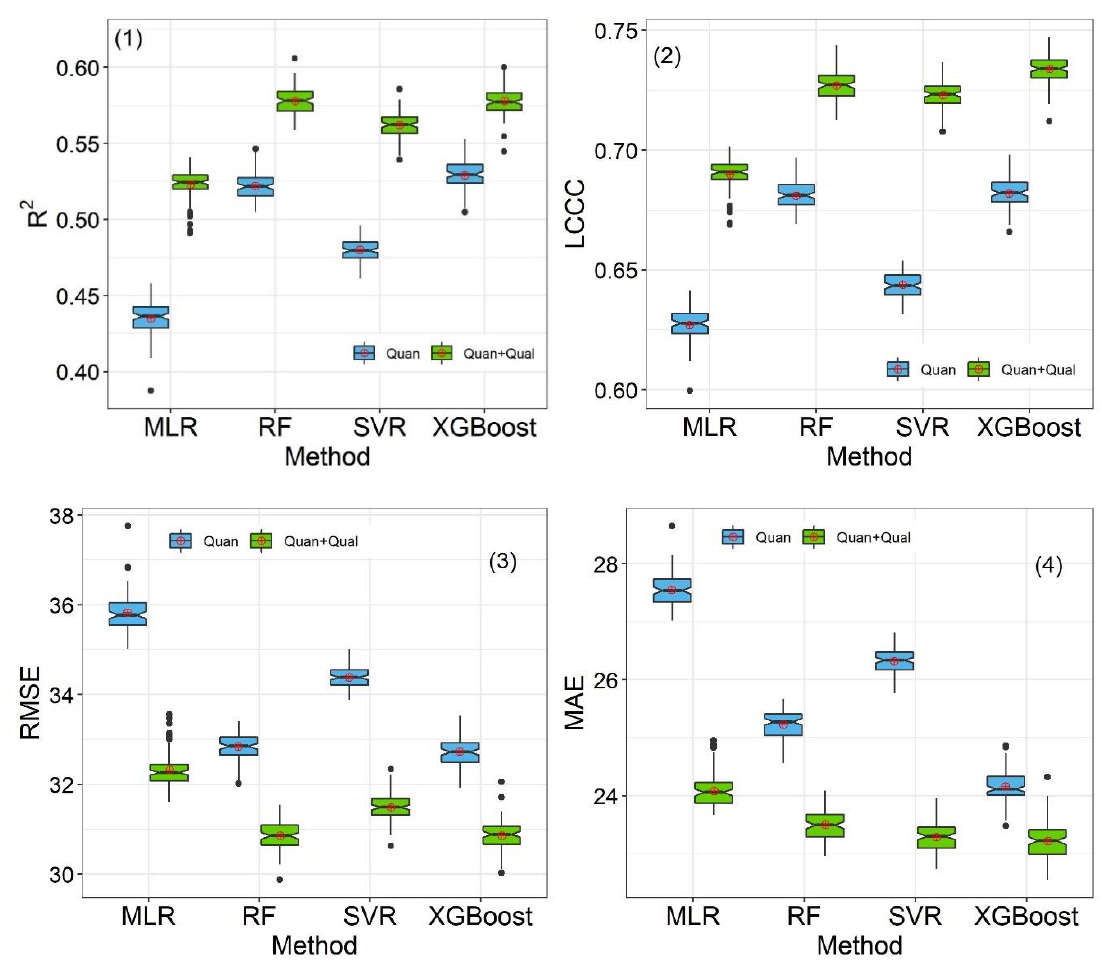
Figure 6. Boxplots of model evaluation criteria for soil thickness prediction using four individual machine learning (ML) models for different input environmental variables (Quan: eleven quantitative environmental variables. Qual: four qualitative variables).